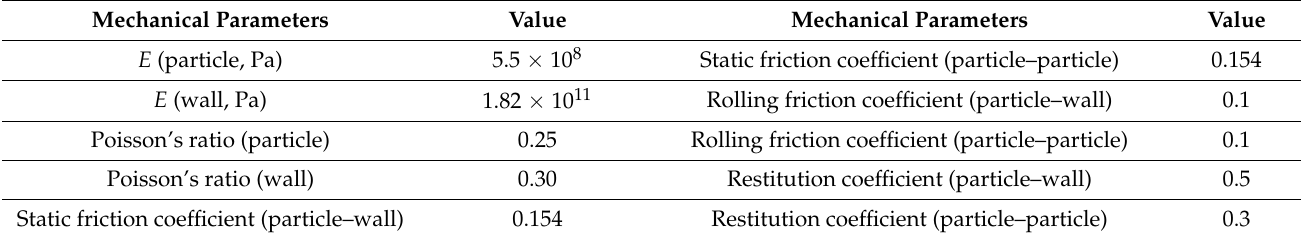
Table 2. The parameters related to the calculated motion of particle to particle and particle to